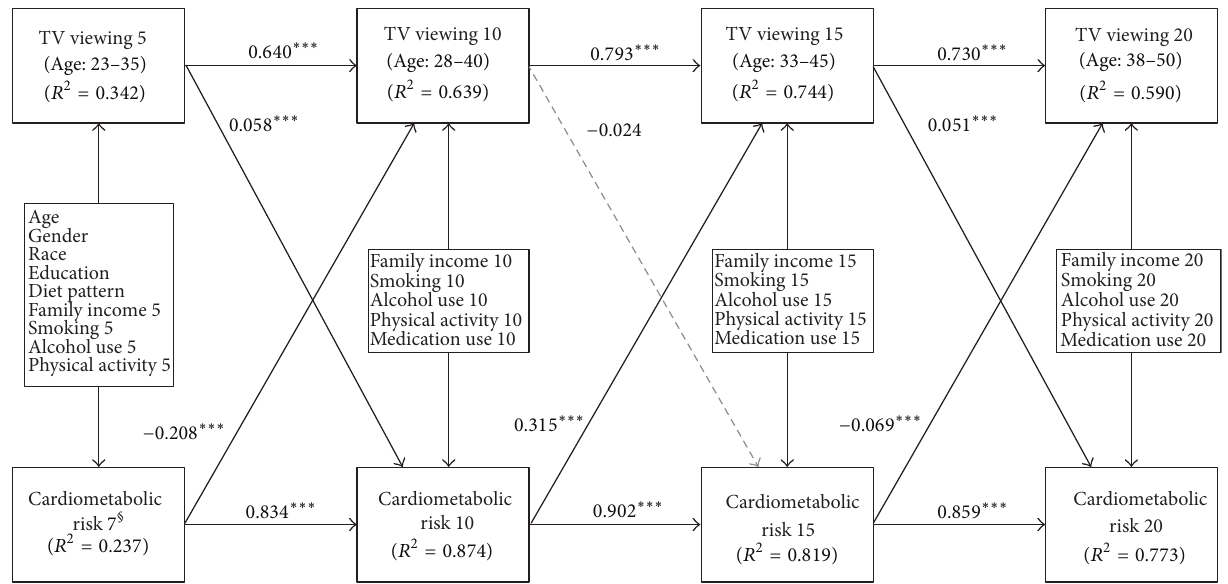
Figure 1: A cross-lagged panel model showing that TV viewing predicts increases in clustered cardiometabolic risk score for the whole population. Regression weights are standardized. R 2 represents the estimated proportion of the assumed underlying continuous variable explained by the model. § Cardiometabolic risk 7 is a surrogate of cardiometabolic risk 5. ∗ 𝑃 < 0.05 ; ∗∗ 𝑃 < 0.01 ; ∗∗∗ 𝑃 < 0.001